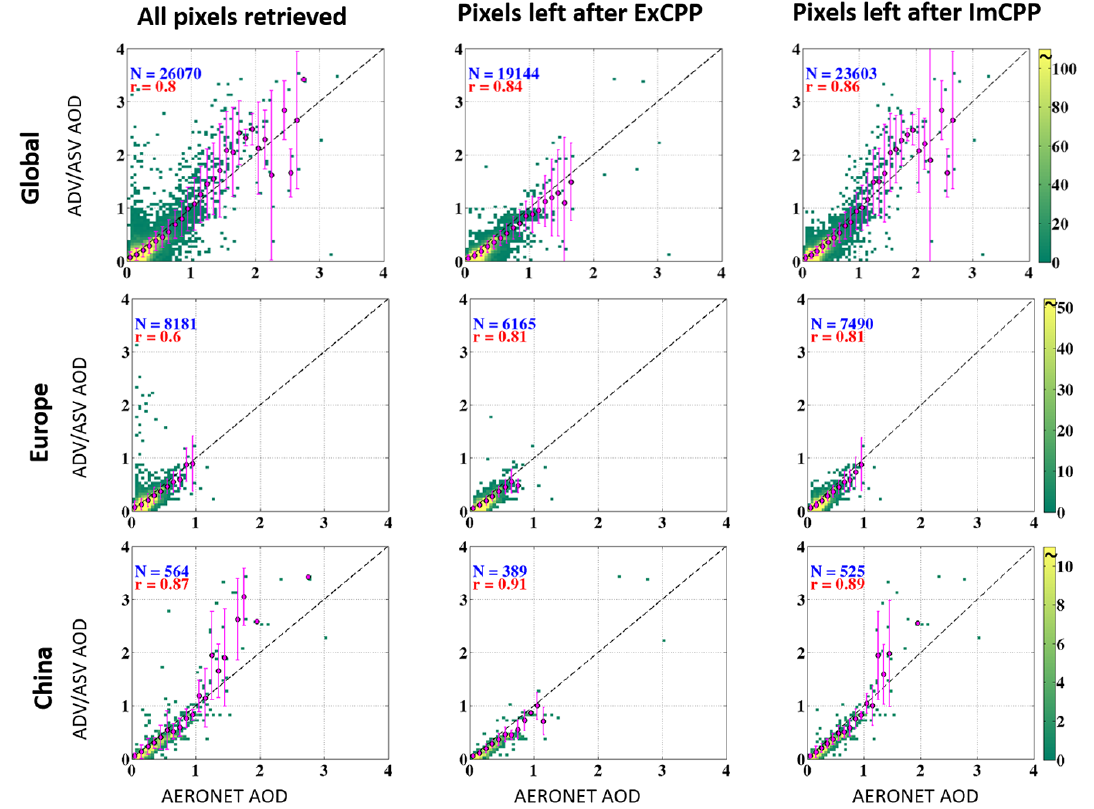
Figure 9. Scatter plots of AOD retrieved with ADV vs. AERONET AOD for all pixels retrieved (left column), for pixels left after application of the existing CPP (ExCPP, middle column) and for pixels left after applying the improved CPP (ImCPP, right column) for the whole world (upper row), Europe (middle row) and eastern China (lower row) for the period of 2002–2012. The black broken line is the identity line; N is the number of pixels accepted for validation, r is the correlation coefficient, magenta dots show ADV-retrieved AOD averaged to the bins, magenta lines show ADV/ASV AOD standard deviation in each bin; colour bar shows the number of ADV/AERONET data